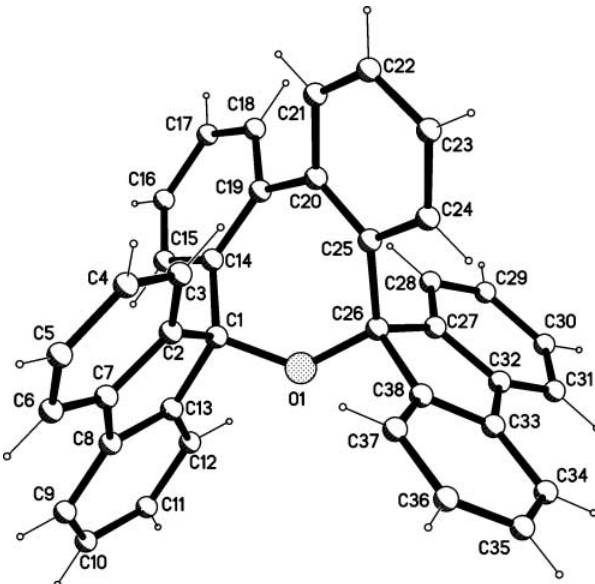
groups with closing of the seven membered ring. The fluorenyl fragments of the title compound are planar while the central heterocycle is in boat conformation.